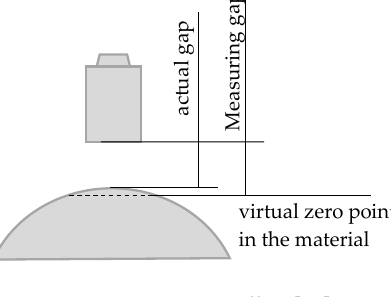
Figure 4. Average effect [14].